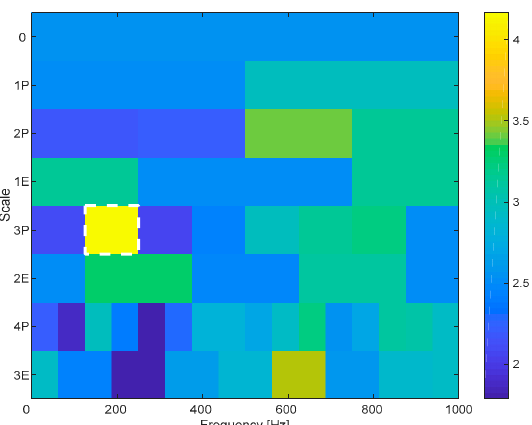
Figure 20. Kurtosis distribution of wavelet packets derived from the displacement signal with strong harmonic component reduction.